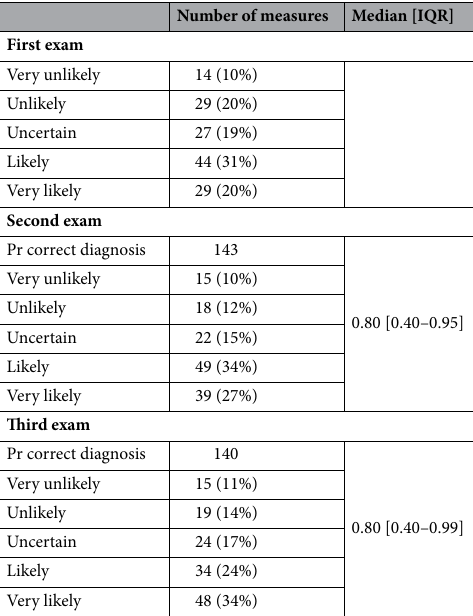
Table 3. Estimated probabilities of correct diagnoses along the sequence of